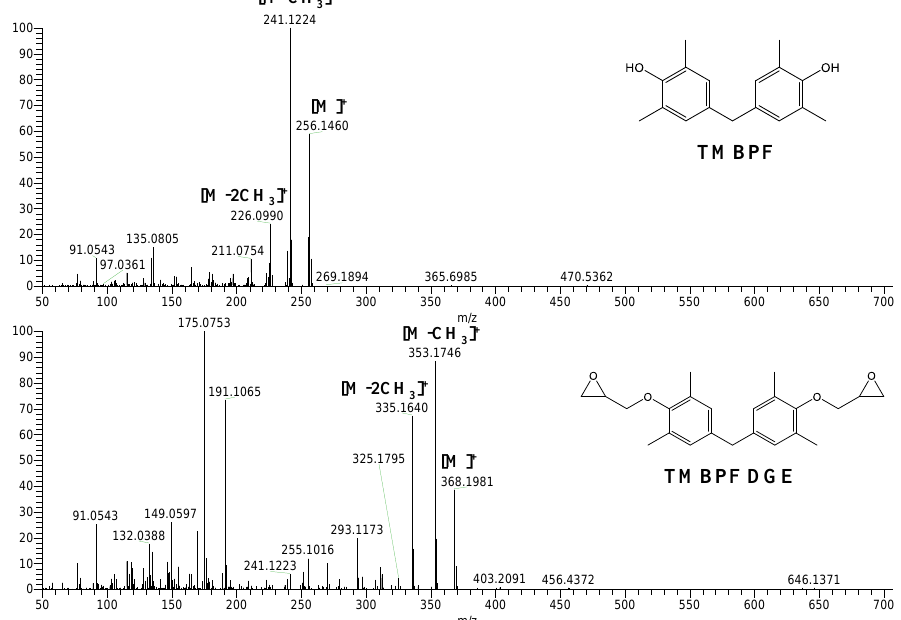
Figure 1. High resolution GC-MS Spectra for tetramethyl bisphenol F (TMBPF) and tetramethyl bisphenol F diglycidyl ether (TMBPF DGE).